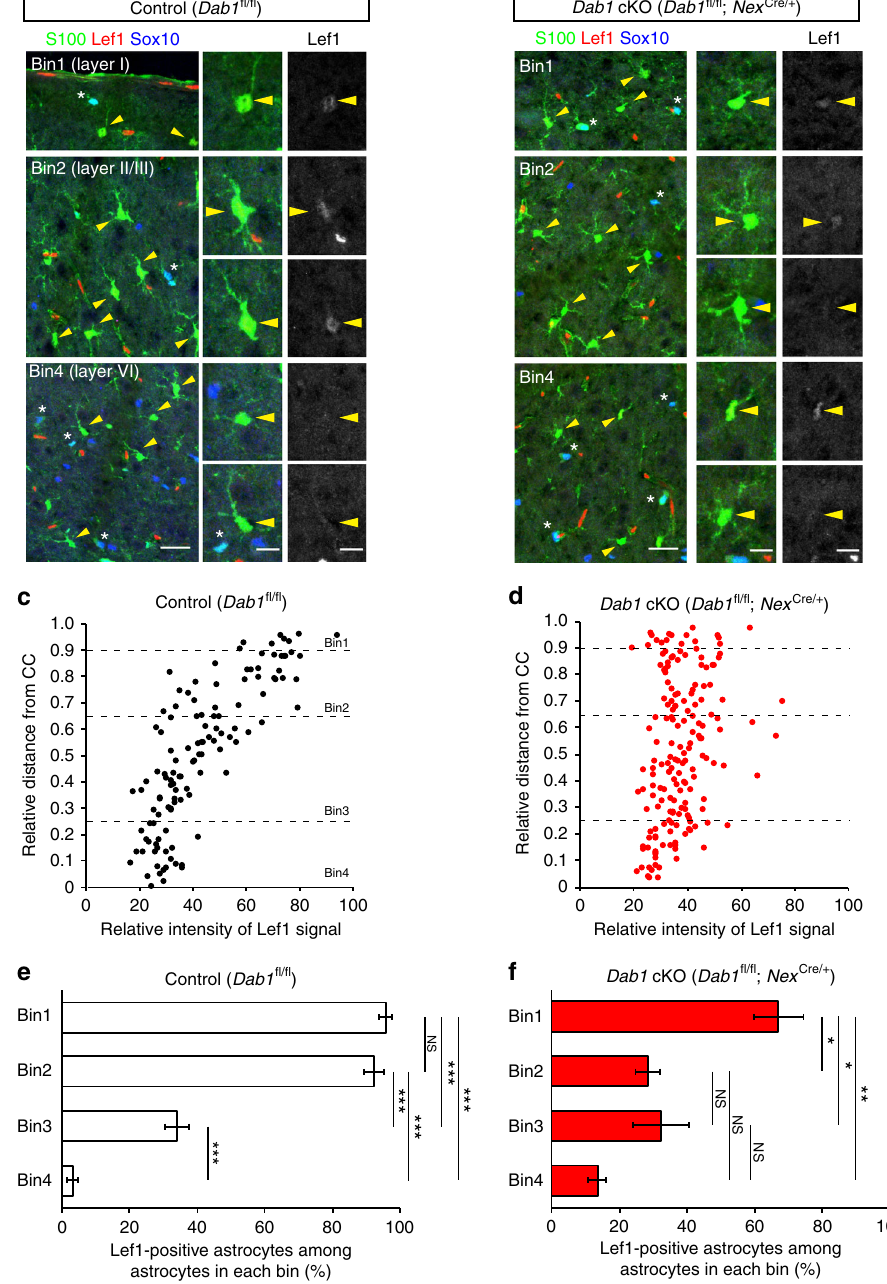
Fig. 5 Layer-speci fi c expression of Lef1 in neocortical astrocytes and its disruption in Dab1 cKO mice. a , b Immuno fl uorescence staining for S100, Sox10, and Lef1 in coronal sections of control ( Dab1 fl / fl ) ( a ) and Dab1 cKO ( Dab1 fl / fl ; Nex Cre/ + ) ( b ) mice at P30. Astrocytes were identi fi ed as S100-positive, Sox10- negative cells (arrowheads); asterisks indicate double-positive cells. Individual astrocytes and Lef1 signals are shown in the right panels at higher magni fi cation. Scale bars, 25 µ m (left panels) and 10 μ m (right panels). c , d Representative data of Lef1 signal intensitiesin the nucleus of individual astrocytes in a coronal section from a control ( c ) and a Dab1 cKO ( d ) mouse. Astrocyte position in the cortical layers is expressed as relative distance from the corpus callosum (CC) to the pia, with dashed lines indicating the boundaries between bins: bin1, 0.9 – 1.0; bin2, 0.65 – 0.9; bin3, 0.25 – 0.65; and bin4, 0 – 0.25. e , f Percentage of Lef1-positive astrocytes among total astrocytes in each bin of the neocortex of control ( e ) and Dab1 cKO ( f ) mice ( n = 3 mice). Perivascular astrocytes are excluded from quanti fi cation. Data are means ± s.e.m. from three mice of each genotype. ** P < 0.01; *** P < 0.001; NS, not signi fi cant (one-way ANOVA followed by Bonferroni ’ s